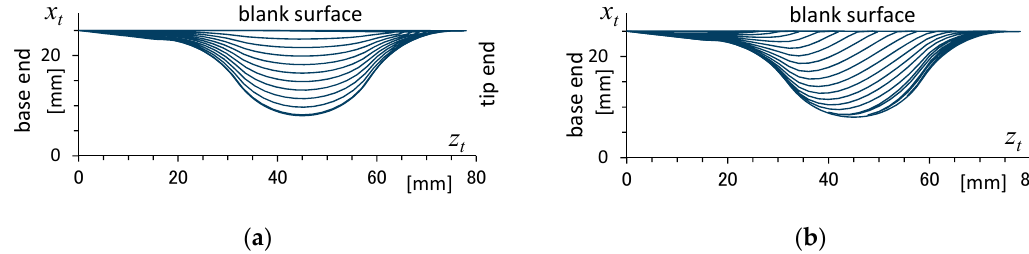
Figure 13. Actual roller paths for samples ( a ) B’ and ( b ) B. x t and z t are the positions of the roller in the radial and axial directions. The origin of the horizontal axes is at the base end of the product.